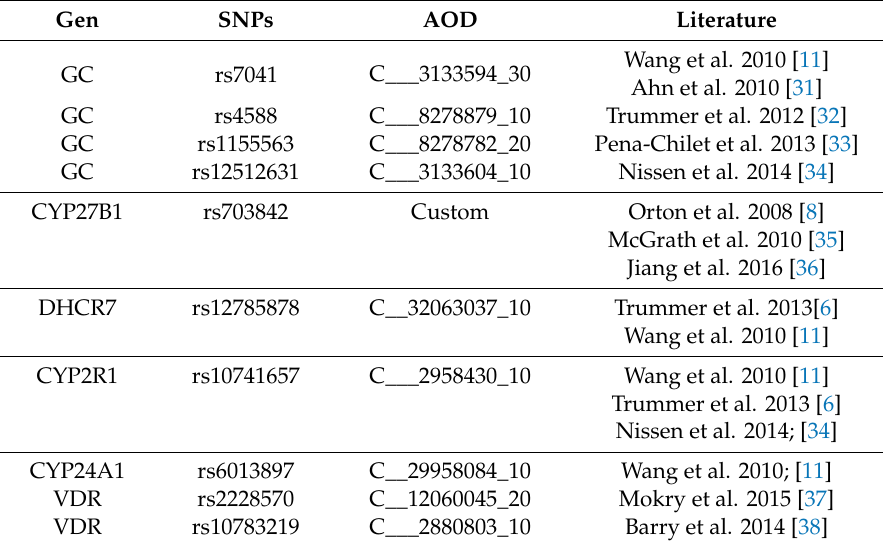
Table 1. Selected single nucleotide